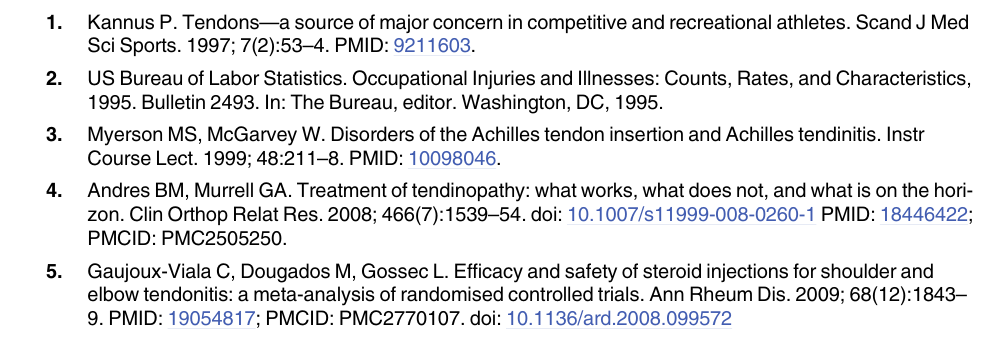
S1 Table. Results of histopathological scoring in Achilles tendons after an intratendinous injection. S2 Table. Results of ED1 + macrophage density in Achilles tendons after an intratendinous injection. S3 Table. Results of ED2 + macrophage density in Achilles tendons after an intratendinous injection. S4 Table. Results of the proportion of IL-1 β + cells in Achilles tendons after an intratendi- nous injection. S5 Table. Results of the proportion of neovascularization in Achilles tendons after an intra- tendinous